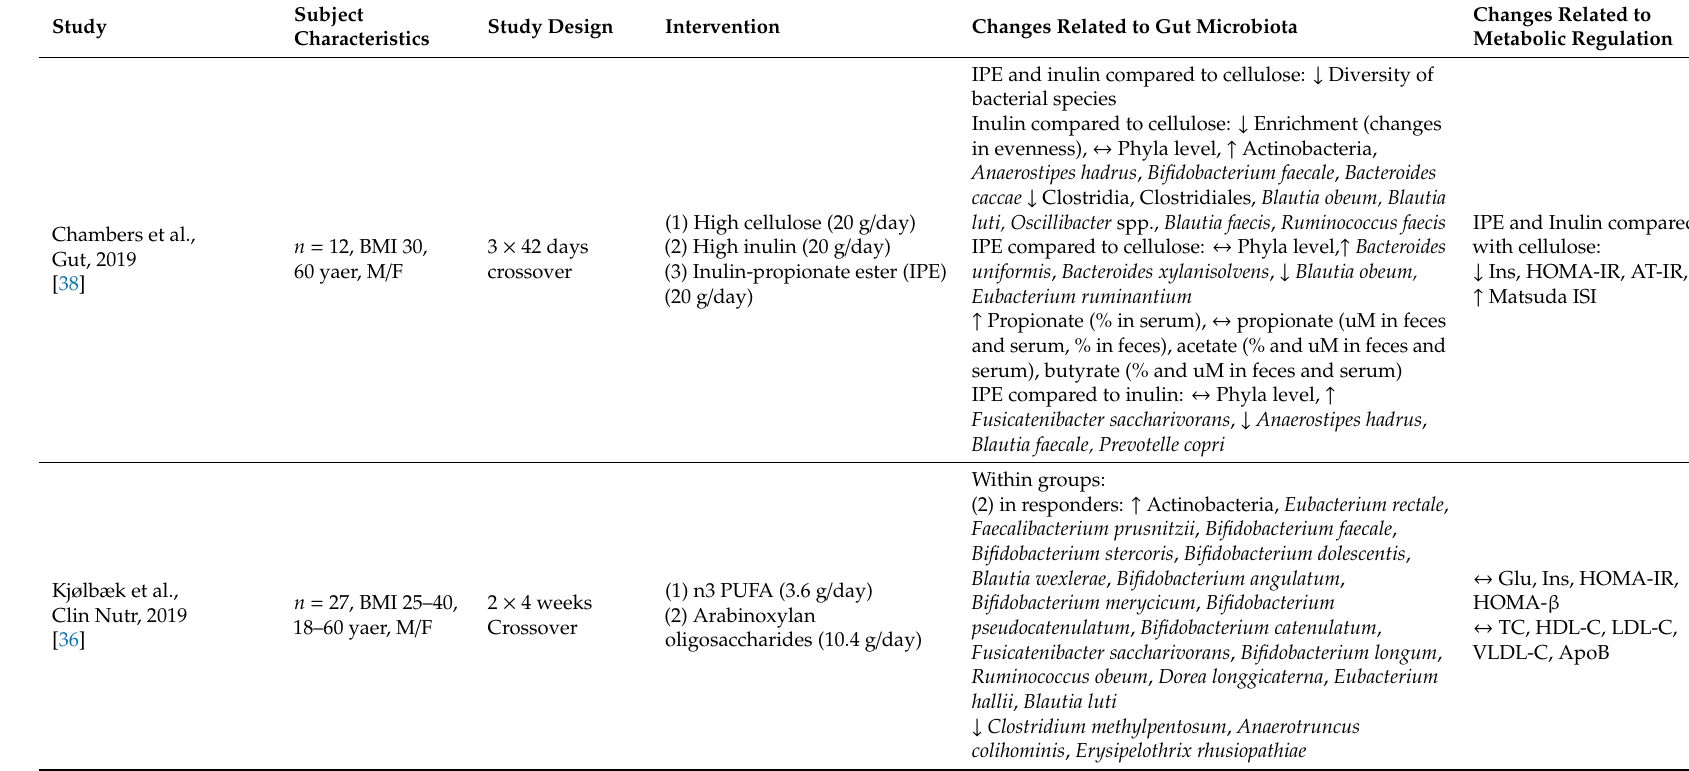
Table 3. Fiber, gut microbiota, and metabolic regulation in overweight and obese individuals. Significant results are indicated by an up / down